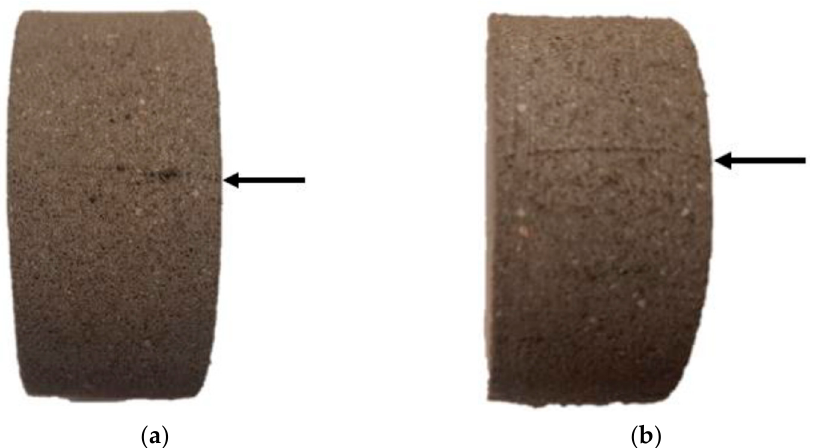
Figure 10. Visible CL, indicated by the black arrow, present in the 3D-20 ( a ) and 3D-30 ( b ) DI sam-